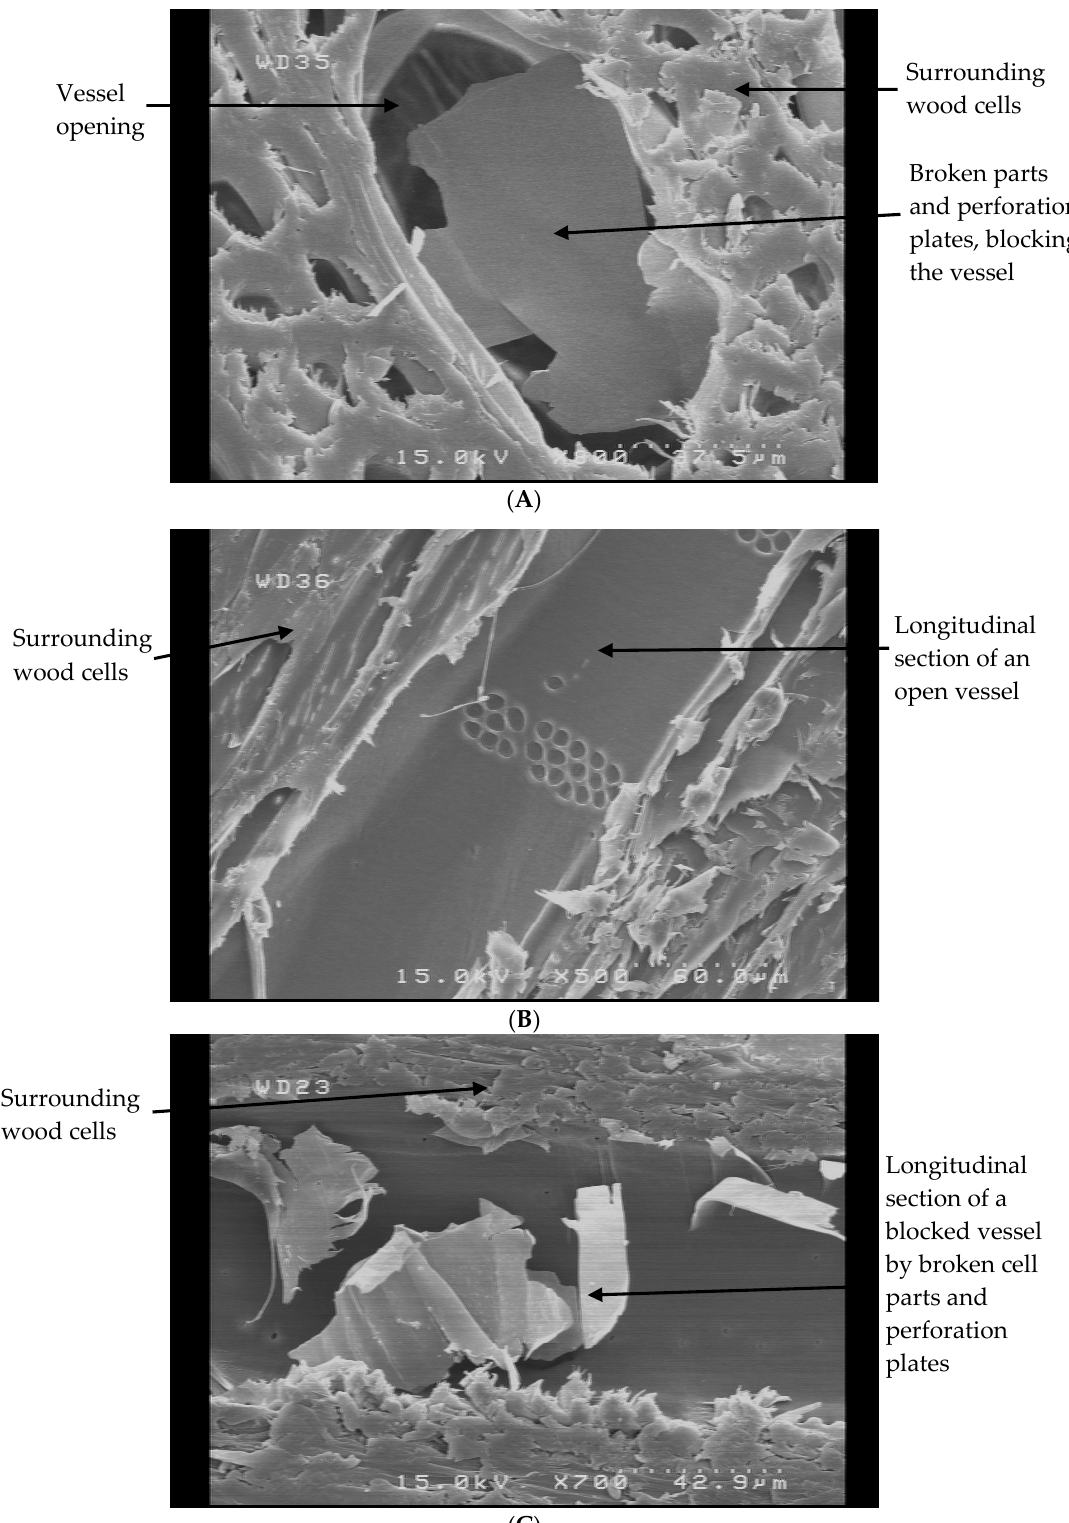
Figure 4. SEM images showing cell parts and perforation plates ( ); ( A ) cross-section of a blocked vessel by distorted and ruptured vessel elements; ( B ) longitudinal section of an open vessel; ( C ) longitudinal section of a vessel blocked by broken cell parts and perforation plates.